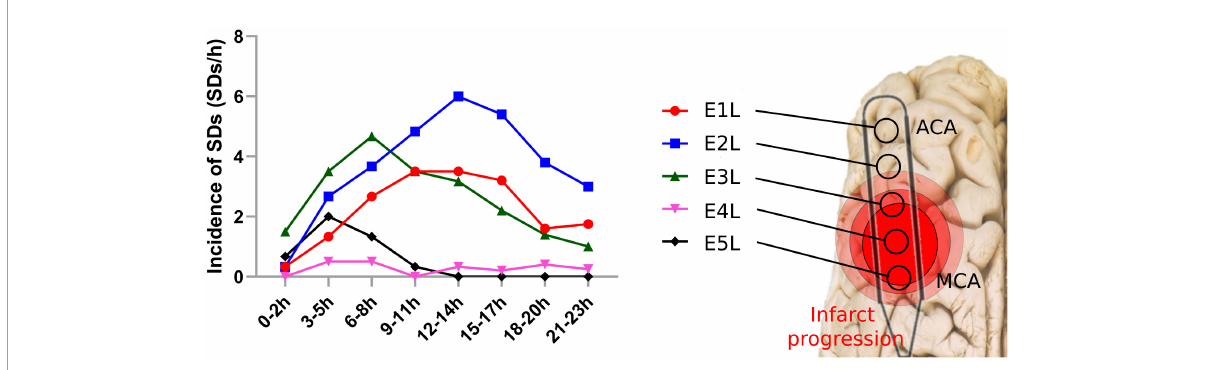
FIGURE4 Spreading depolarization incidence after MCAo in each electrode. SDs were quantified in each electrode of the affected hemisphere after the MCAo. SD, spreading depolarization; MCAo, middle cerebral artery